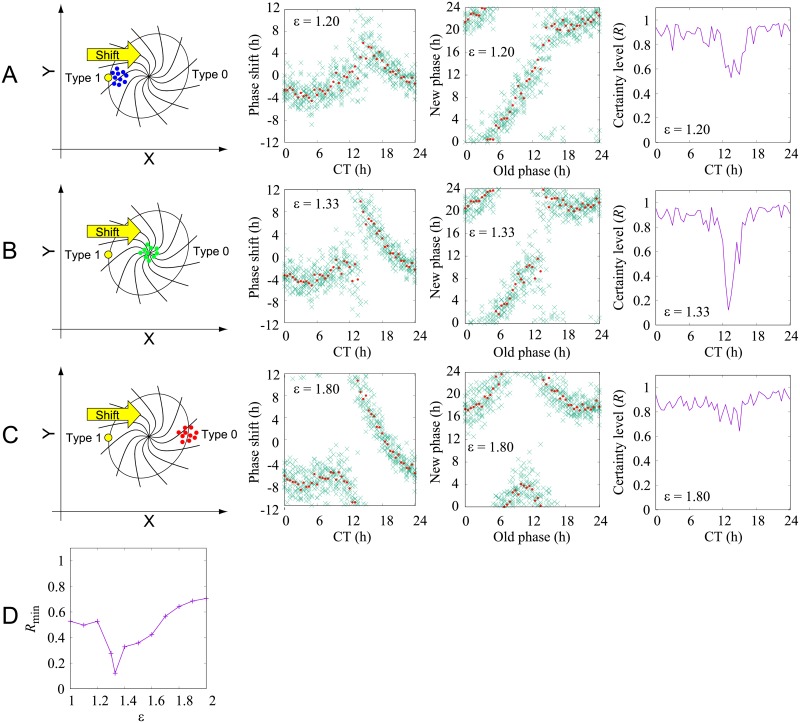
Computational simulation with noise and conceptual scheme of a state point behavior after several intensities of perturbation.(A–C) Schematic drawings of a limit cycle attractor and a perturbation delivered to the system are shown in the left column. An oscillator (yellow) circulates in the phase plane (X, Y) as shown in Fig 1. A unique point in the center of the trajectory was the assumed as a singular point where all isochrones converge. When perturbations of varying intensity (yellow arrow) were applied to the oscillator, the oscillator deviated from the trajectory by various distances. (A) In the weak intensity case (blue dots), the oscillator moved in the vicinity of the trajectory where the phase difference was small (type 1 phase resetting). (B) In the moderate case (green dots), the oscillator reached close to the singular point. (C) In the strong case (red dots), the oscillator moved to the opposite area of the trajectory, giving the large phase shift (type 0 phase resetting). The middle column shows the phase response φj (j  =  1, …30) for each perturbation timing CT (crosses) and mean phase Φ (CT) (filled circles). The right column shows the certainty level R (CT). (D) Minimum of R for each ε value.